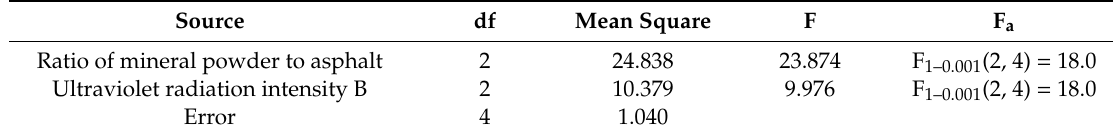
Table 7. Analysis for the ratio of asphalt mortar on